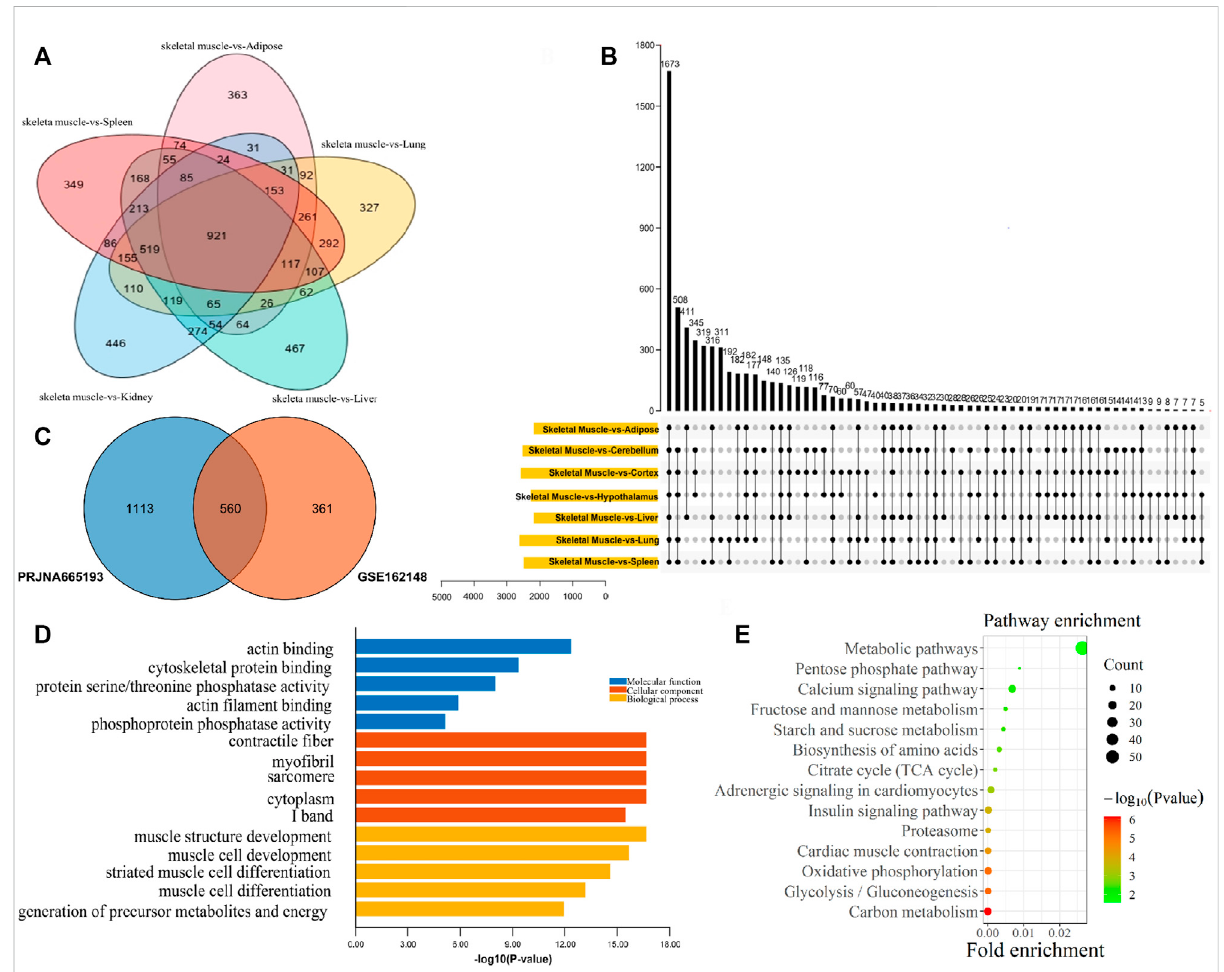
FIGURE 3 Functional enrichment analysis of muscle-speci fi c highly expressed genes. (A) Venn diagram of DEGs from the GSE162148 dataset; (B) Venn diagram of DEGs from the PRJNA665193 dataset; (C) overlapping DEGs between the postnatal-speci fi c high-expressed gene set and the muscle- speci fi c high-expressed gene set; (D) GO enrichment analysis results of muscle-speci fi c highly expressed genes; and (E) KEGG enrichment analysis results of muscle-speci fi c highly expressed